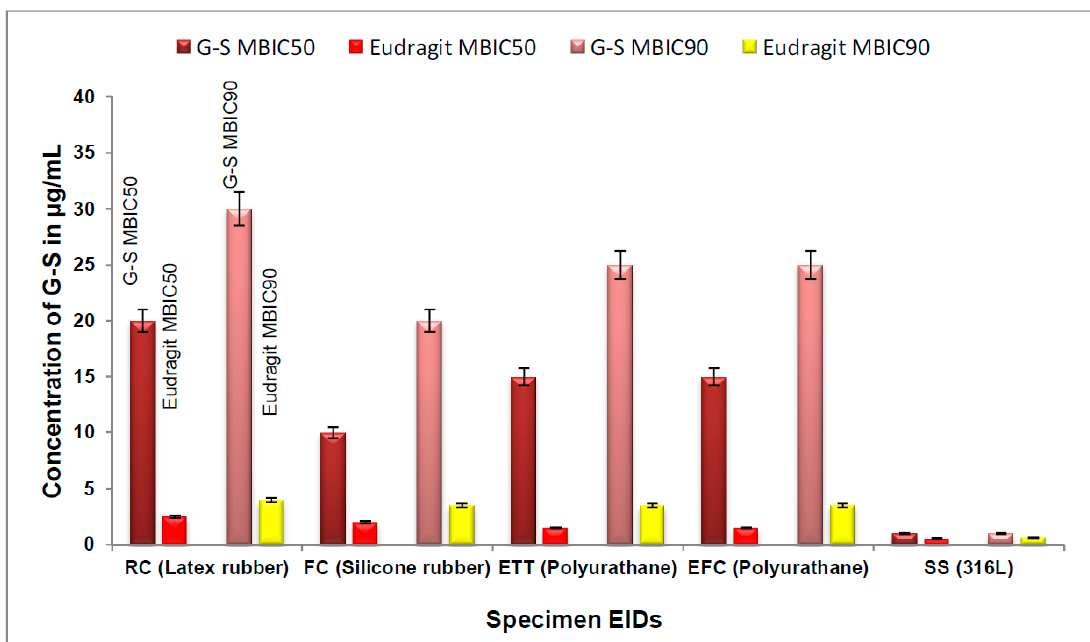
Figure 8. Comparision of minimum biofilm inhibitory concentration (MBIC): MBIC 50 and MBIC 90 of G-S and E-G-S.